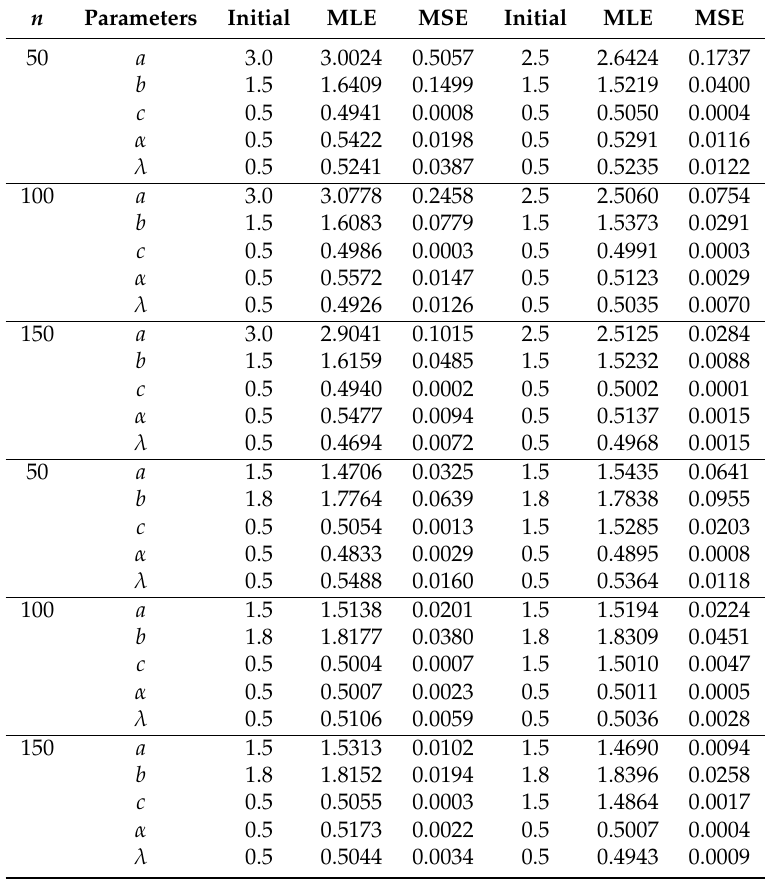
Table 1. The MLEs and MSEs of MBGz